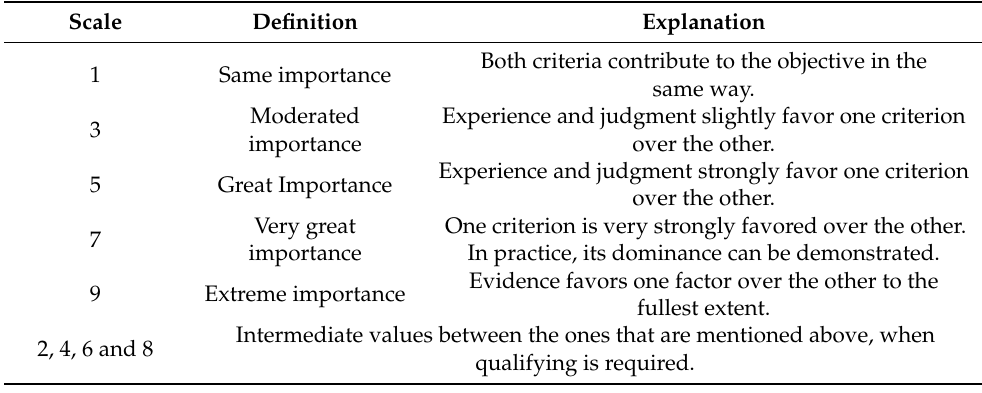
Table 2. Saaty Fundamental Scale for pairwise comparison